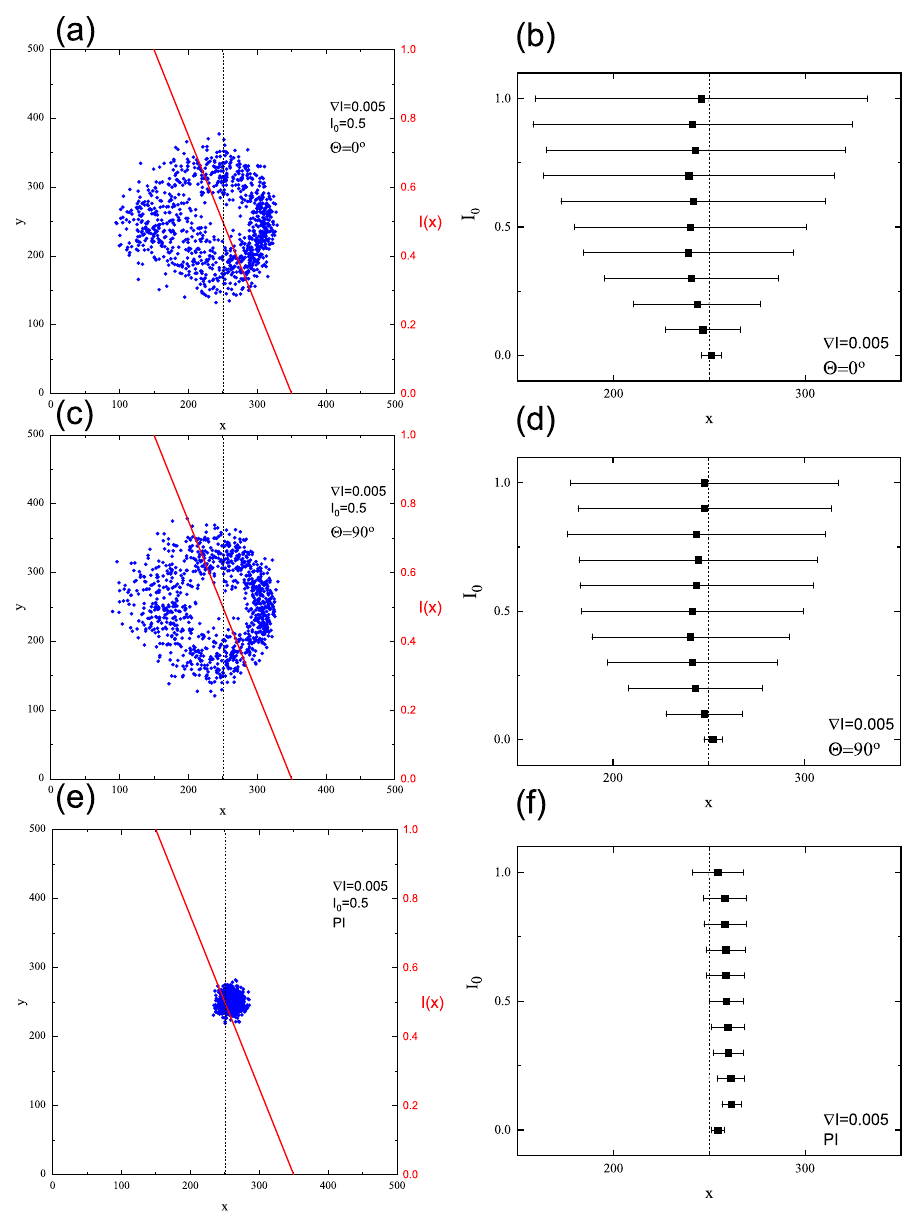
Figure 11. Final positions of CM of chains after 10 4 MCS and averaged position in x direction with standard deviation σ x ( I 0 ) : for FPM with linear polarization with Θ = 0 ◦ ( a , b ) and Θ = 90 ◦ ( c , d ); and for PI model ( e , f ). ∇ I = 0.005, I 0 =